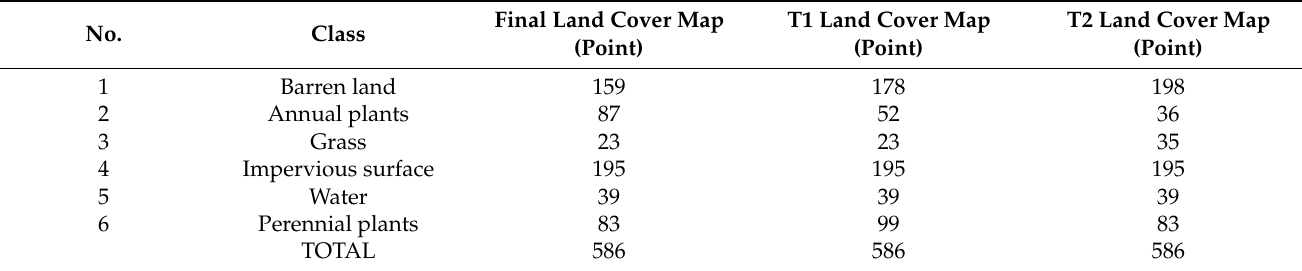
Table A2. Summary of validation data for land cover